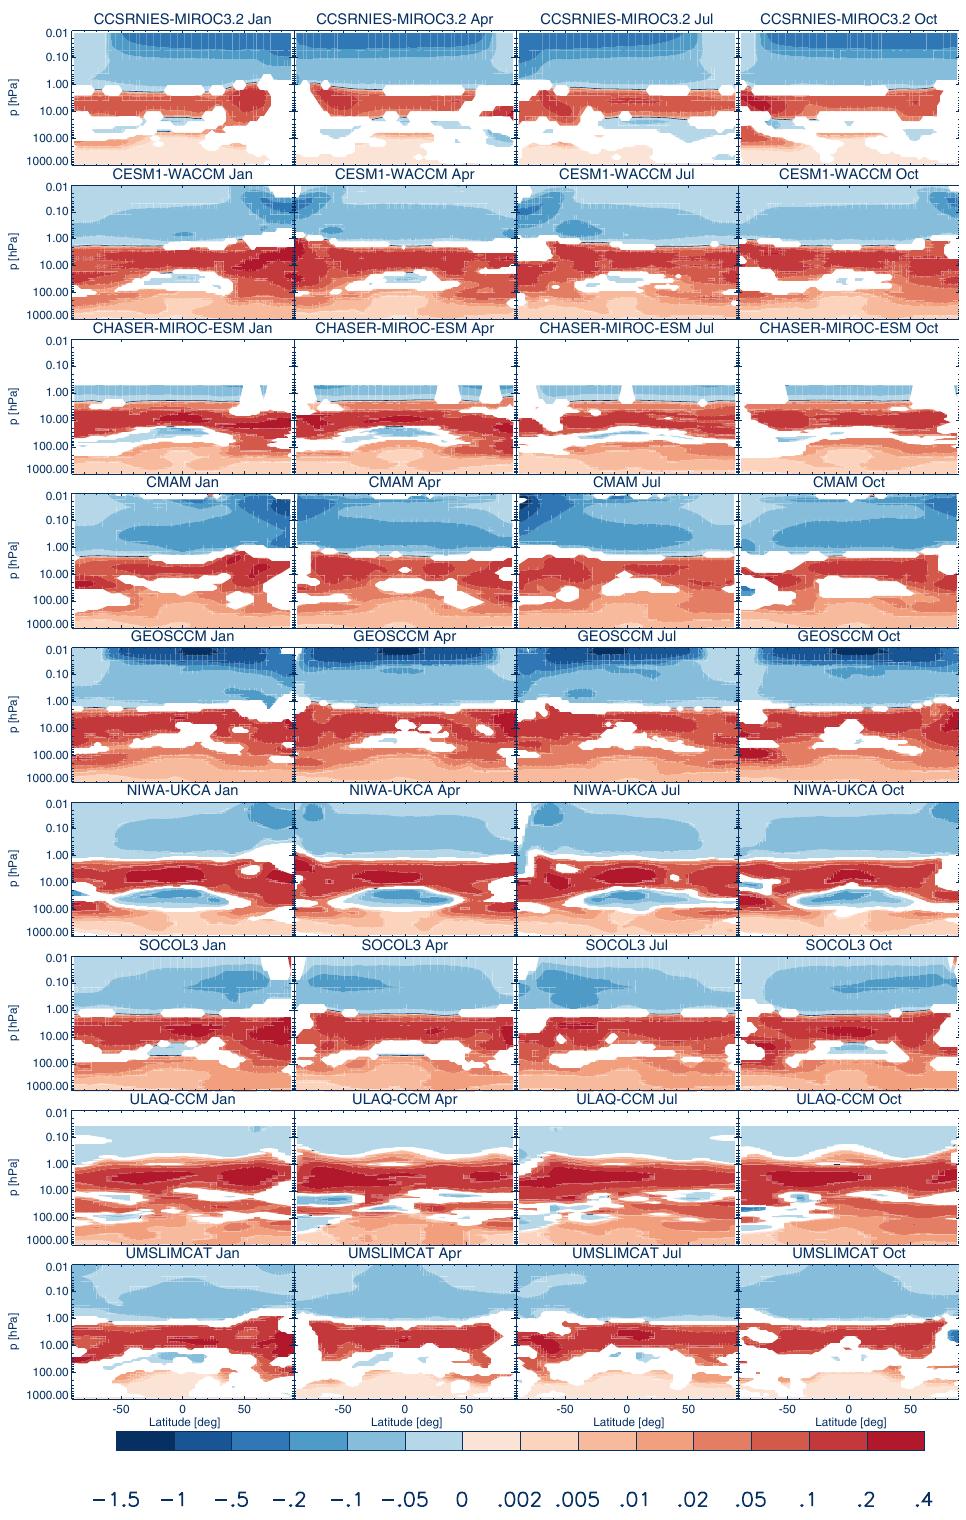
Figure 1. Ratio of zonal-mean ozone volume mixing ratio changes to VMR changes in surface CH 4 ( a ) as derived from the REF-C2 and SEN-C2-fCH4 simulations. a is dimensionless. The colour white indicates that a is not significantly different from 0 at the 95% confidence interval. The plots for CHASER-MIROC-ESM and ULAQ-CCM have no data above 0 . 5 and 0 . 04hPa,